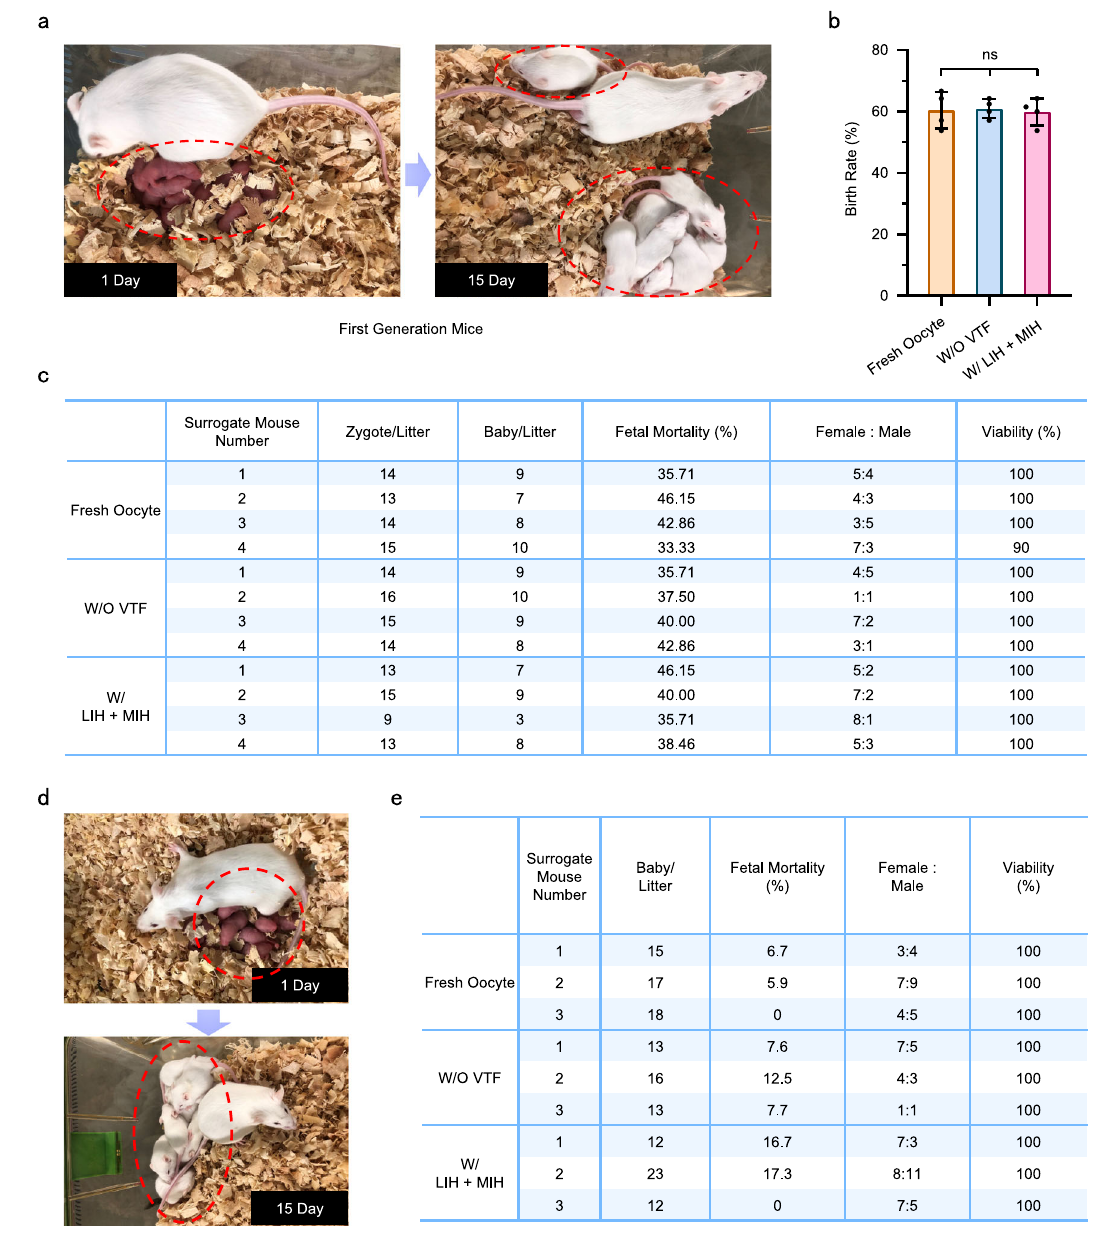
Fig. 7 | Birth of offspring after transplantation of 2-cell stage zygotes. a Mouse pups were born after transplantation of 2-cell stage embryos. b Analysis of the mouse birth rate. c Reproductive performance after zygote transfer. d Birth of the second generation of mice. e Reproduction performance of the fi rst generation of mice. W/O VTF: PAFs were only encapsulated in hydrogel and did not undergo vitri fi cation; W/ MIH+LIH: PAFs encapsulated in hydrogel were warmed with MIH